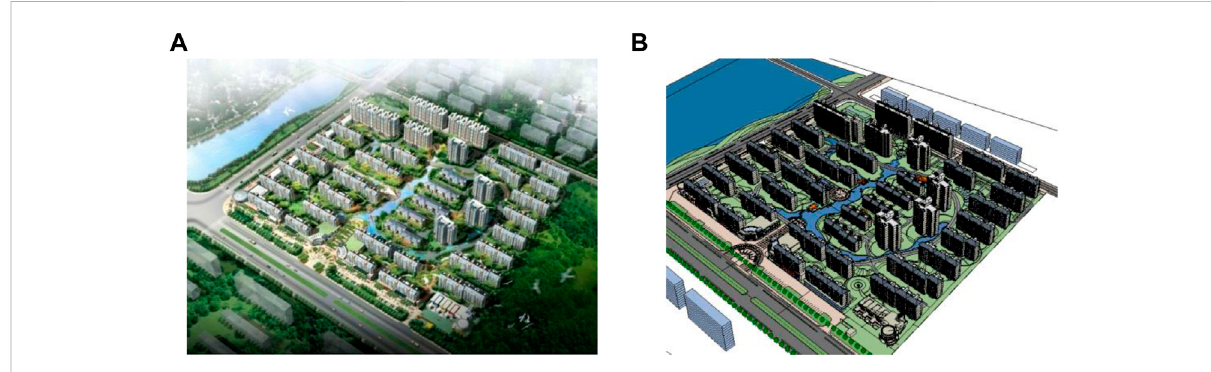
FIGURE 1 Overview of the community (A) rendering the design view; (B) sketch-up model